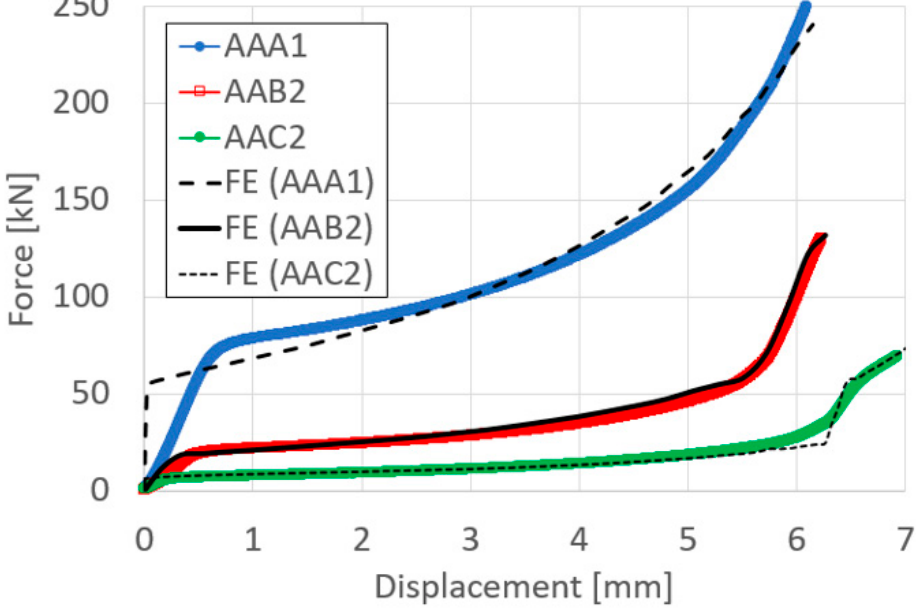
Figure 5. Experimental Vs computed force–displacement curves of the couples of Al6061 compressed at the following temperatures: 300 °C, 400 °C, and 500 °C.